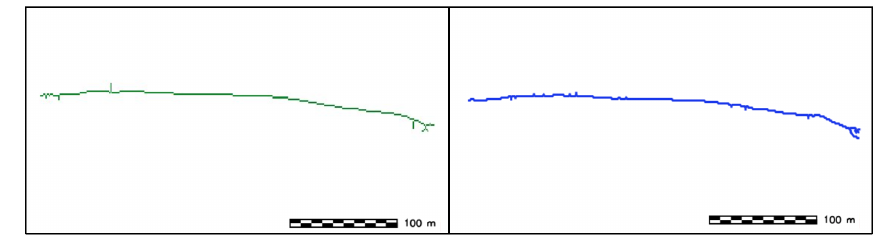
Figure 11. SWC vectorization.